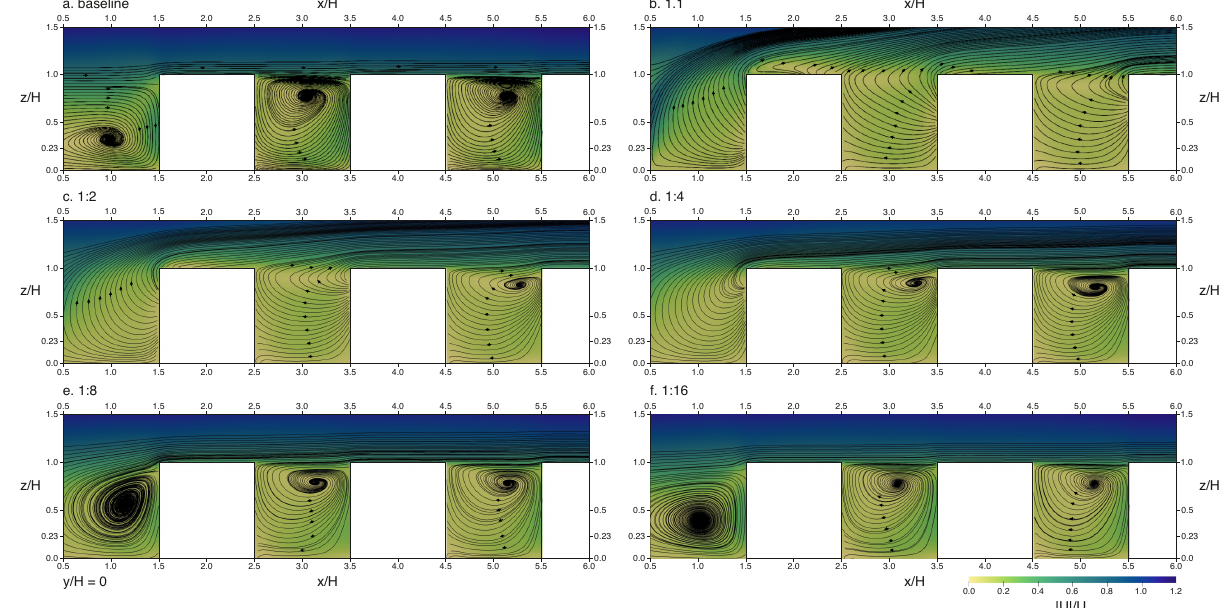
Figure 5. Velocity streamlines for the cases with a warmer water body ( ∆ T = + 2 K) of different sizes over a vertical plane at y / H = 0 in the downwind canyons ( − 0.5 ≤ x / H ≤ 7.5). Normalised velocity magnitude is depicted spatially in the background: ( a ) baseline scenario; ( b ) original size ( S_1:1 ); ( c ) half the original size ( S_1:2 ); ( d ) a quarter of the original size ( S_1:4 ); ( e ) one-eighth of the original size ( S_1:8 ); ( f ) one-sixteenth of the original size ( S_1:16 ). Figure 8 shows the normalised streamwise and spanwise velocity profiles over a horizontal line across the middle of the street canyon ( y / H = 1) at pedestrian level for the warm water body cases. In Figure 8a, the streamwise velocity profiles match in the upwind water body area as the influence of buoyancy is only felt along the direction of the prevailing wind. In the 0 ≤ x / H ≤ 1.5 region, streamwise velocities increase for all cases. Beyond the open square ( x / H > 1.5), further increased values are observed, with the exception of the S_1:16 case which collapses to the profile of the baseline scenario. Results in Figure 8b for the S_1:1 case suggest that the strong vertical plume leads to negative values of spanwise velocity both in the open square and downwind canyons, indicating increased